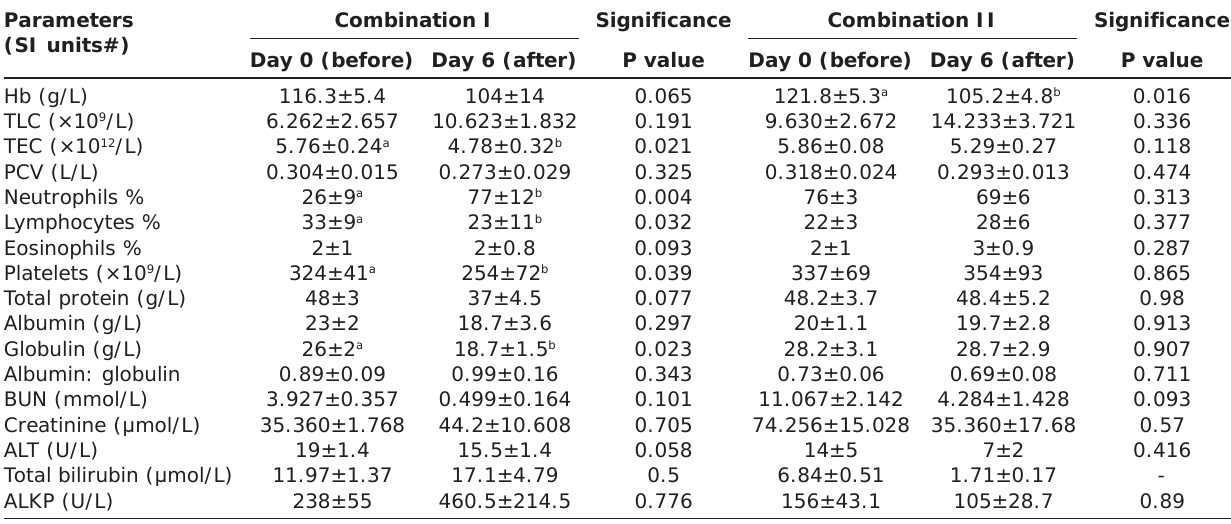
Table-1: Hemato-biochemical alterations before and after administering Combination I and Combination II therapy (mean±SE). Parameters (SI